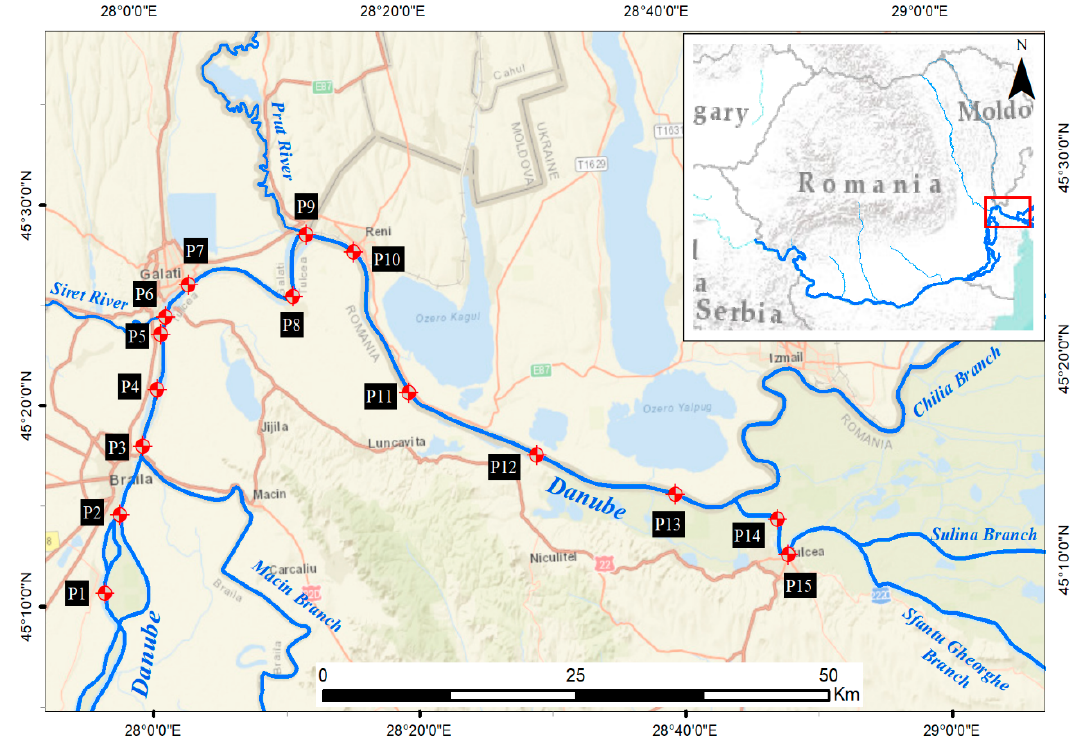
Figure 1. Distribution of the sampling points in the Romanian Lower Danube study area.